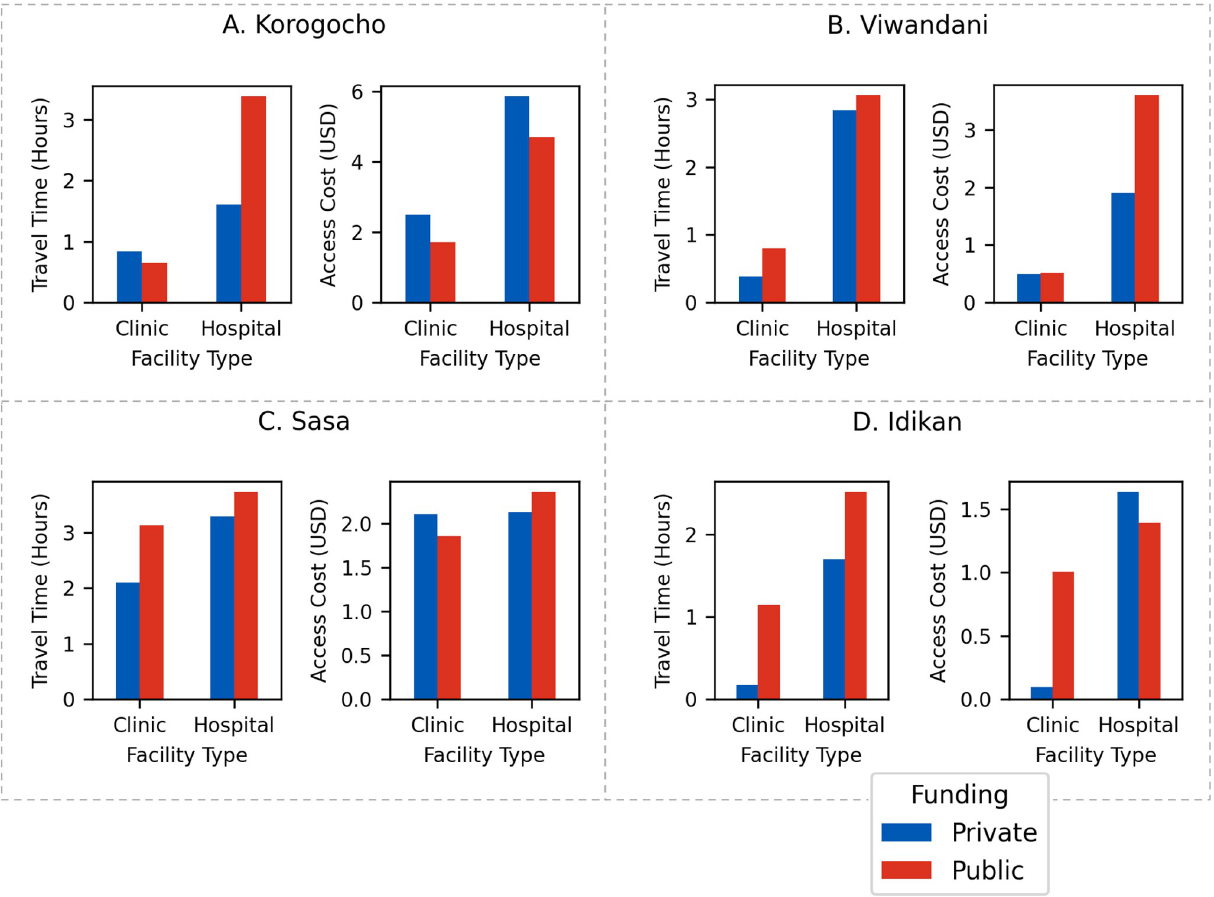
Fig 4. Bar plots for each slum showing the mean travel time and the mean access cost to each of the four HCP classes.